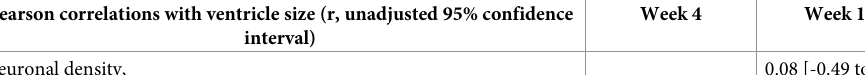
Pearson correlations with ventricle size (r, unadjusted 95% confidence Week 4 Week 10 interval) Neuronal density, 0.08 [-0.49 to 0.60] Microglia density, 0.23 [-0.36 to 0.69] Striatum fibre myelin 0.43 [-0.23 to 0.82] Estimates with unadjusted 95% confidence intervals of the Pearson correlations were calculated across control and treated rats between ventricle cross-sectional area and anatomical variables, DTI and MRE measurements at weeks 4 and 10, and histological results at week 10. Abbreviations: Diffusion Tensor Imaging (DTI); Fractional Anisotropy (FA); Mean Diffusivity (MD); Axial and Radial Diffusivity (AD and RD); Magnetic Resonance Elastography